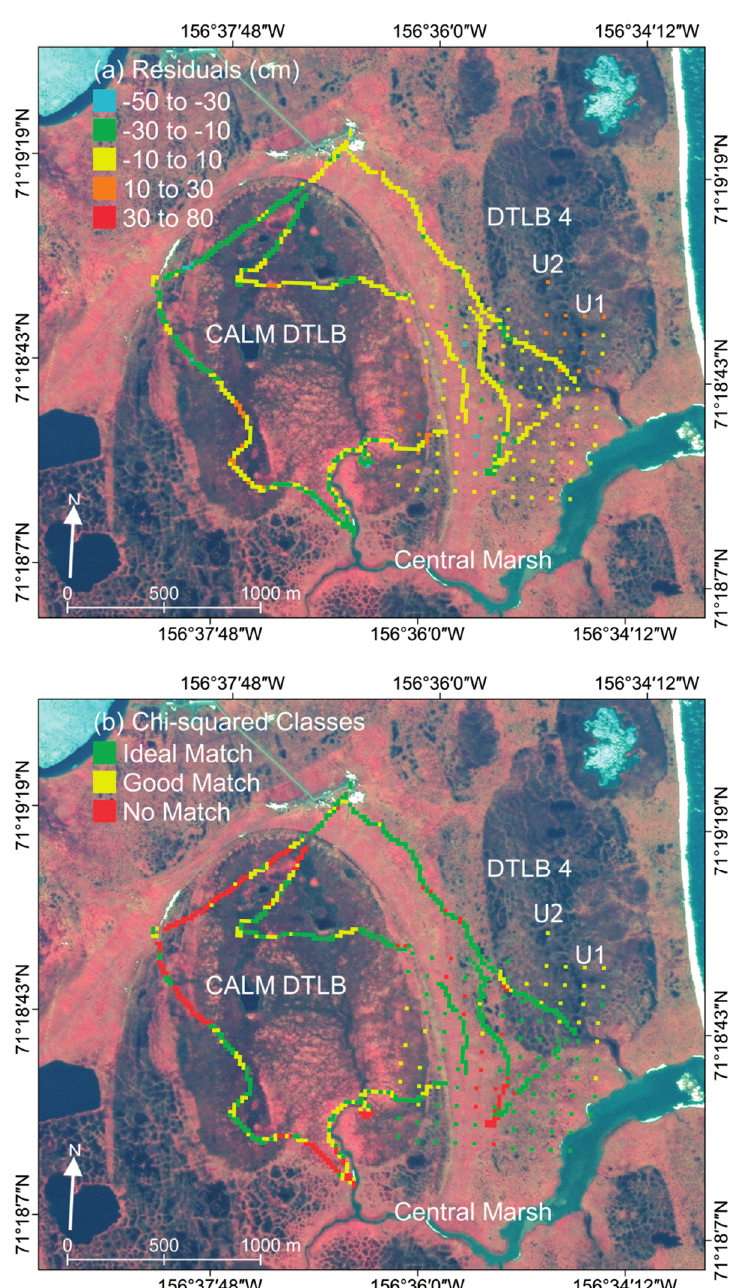
Figure 7. Residuals ( a ) and χ 2 classes ( b ) between the observed ALT and ReSALT at the Circumpolar Active Layer Monitoring (CALM) Site. The site consists of two DTLBs separated by a narrow strip of undisturbed tundra and includes the U1 and U2 CALM sites. The GPR data appear as lines, the U1 CALM data appears as a 1-km grid in the southeast, and the U2 CALM data as a single pixel in DTLB